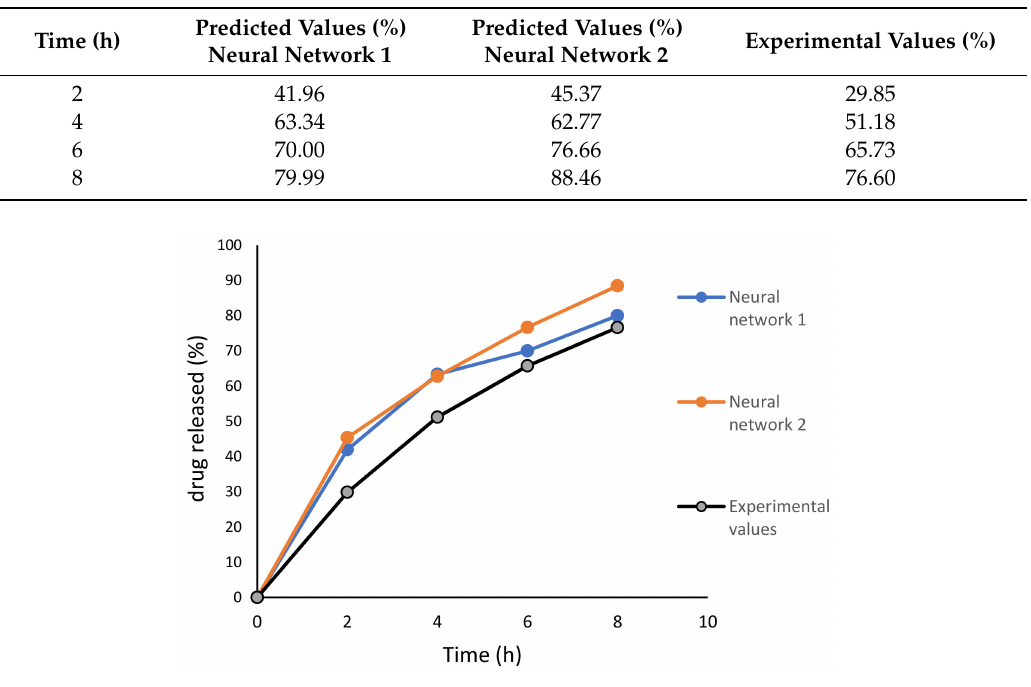
Table 6. Predicted and experimental in vitro release values at time points of 2, 4, 6, and 8 h for optimal formulation of 3D DLP printlets.